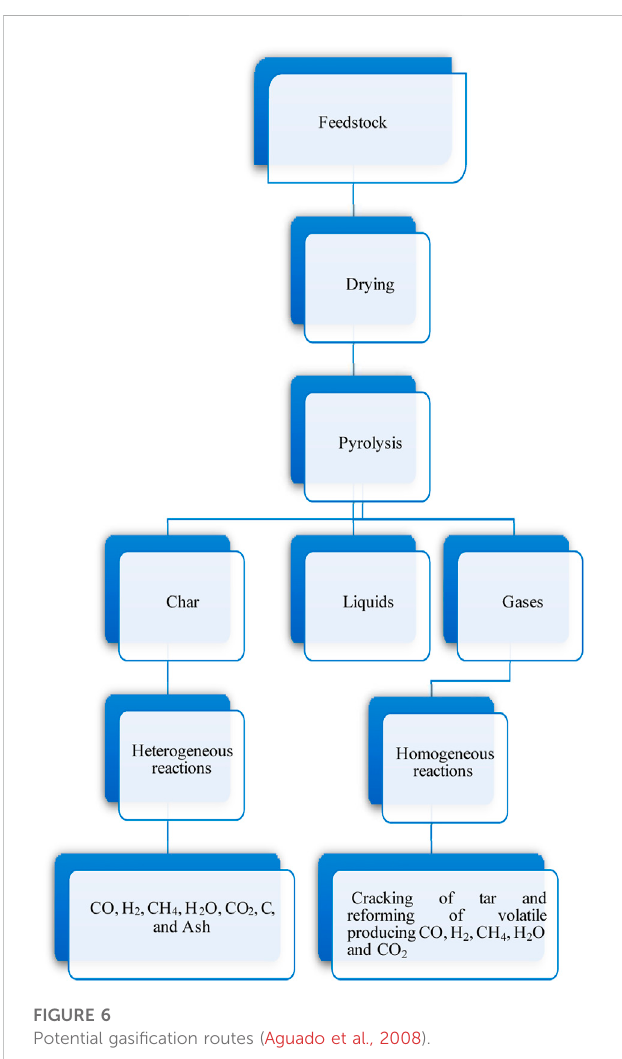
FIGURE 6 Potential gasi fi cation routes (Aguado et al.,